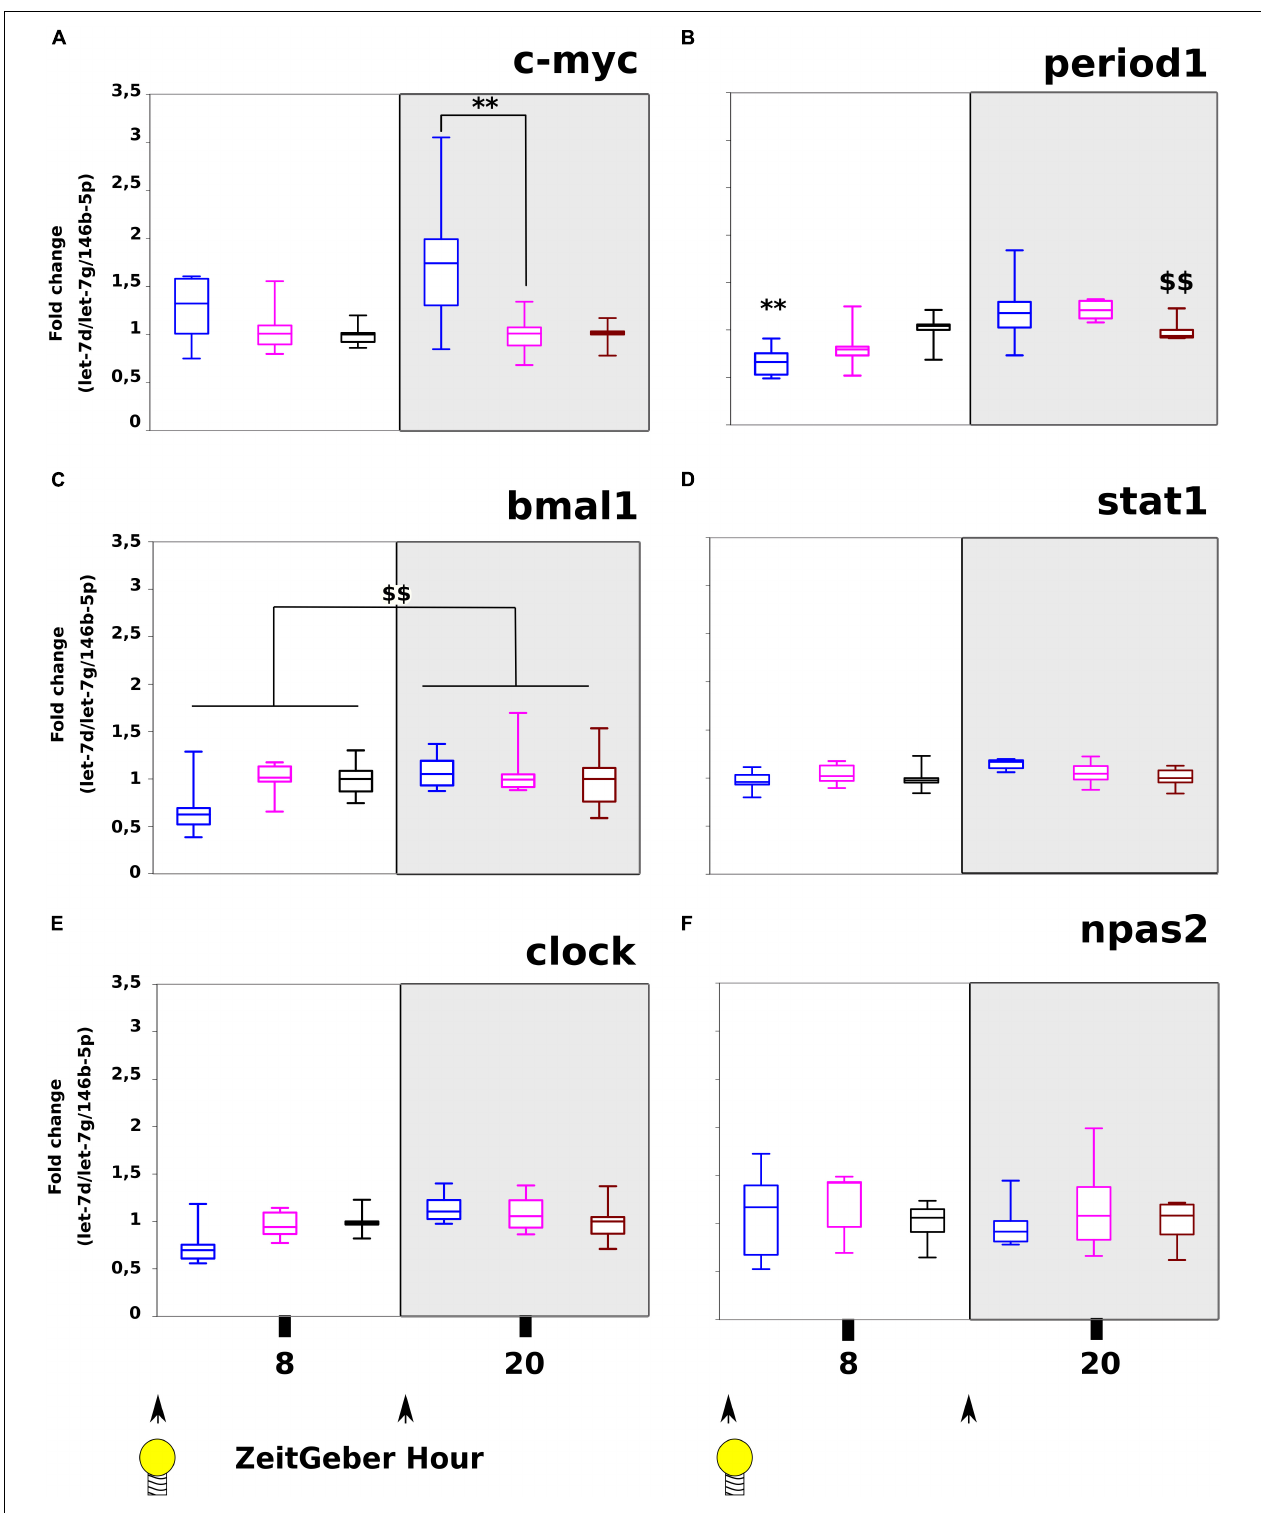
FIGURE 4 | Evaluation of c-myc, circadian clock transcripts and stat-1 following miR-320-3p or antagomiR oral delivery. The mRNA levels of c-myc (A) , period1 (B) , bmal1 (C) , stat1 (D) , clock (E) , and npas2 (F) were assayed in stomach according to a bolus with mir-320-3p (blue box border), antagomiR-320-3p (magenta), or control (black box border). In the box plots, a black line within the box marks the median. The boundary of the box closest to zero indicates the 25th percentile and